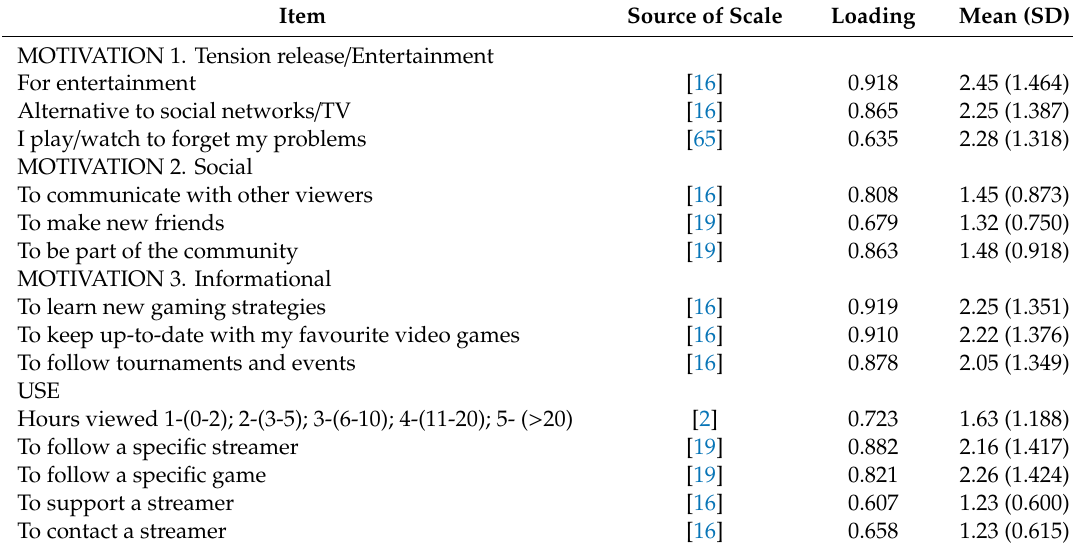
Table 2. Measurement model. Descriptive statistics and